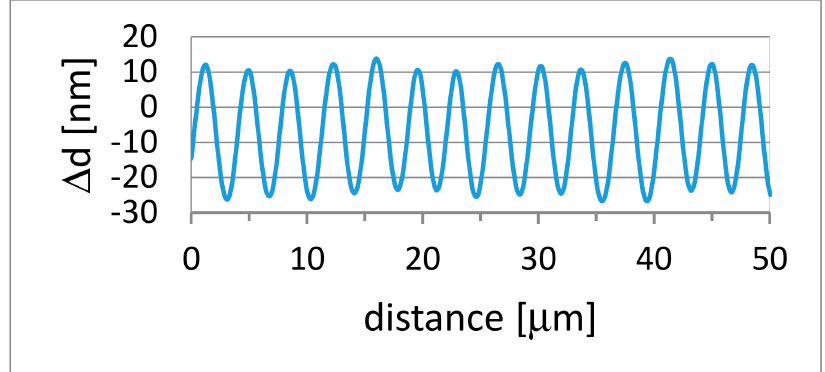
Figure 9. Surface profile measured for qA-N(CH 3 ) 2 with a stylus